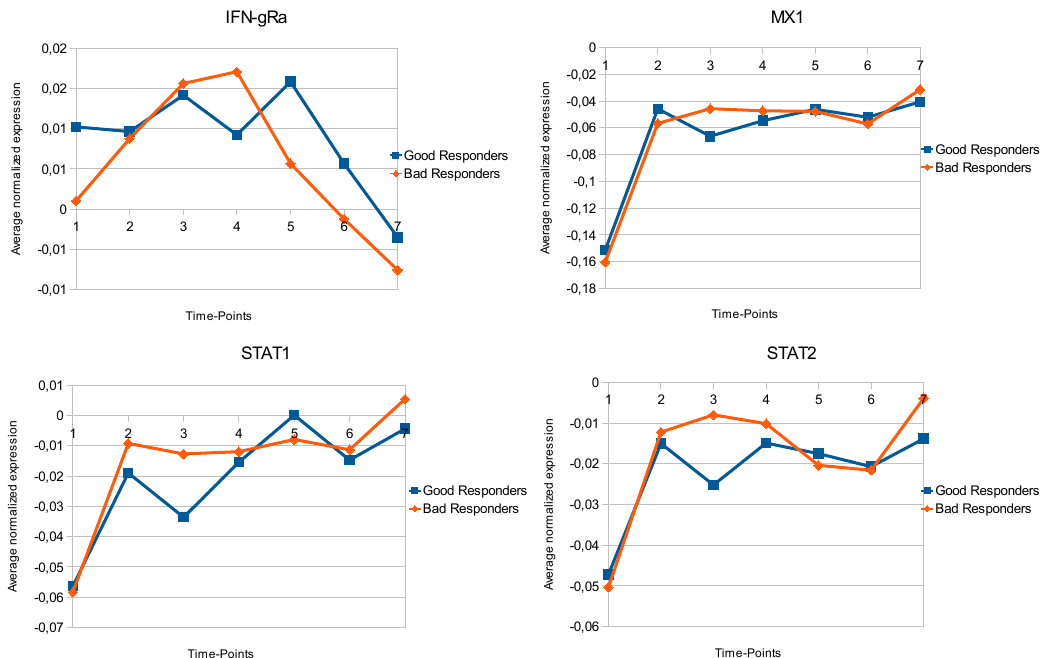
Figure 6: Graphical representation of the averaged normalized expression of good and bad re- sponders, for four different genes, in clockwise order: IFN-gRa, MX1, STAT1 and